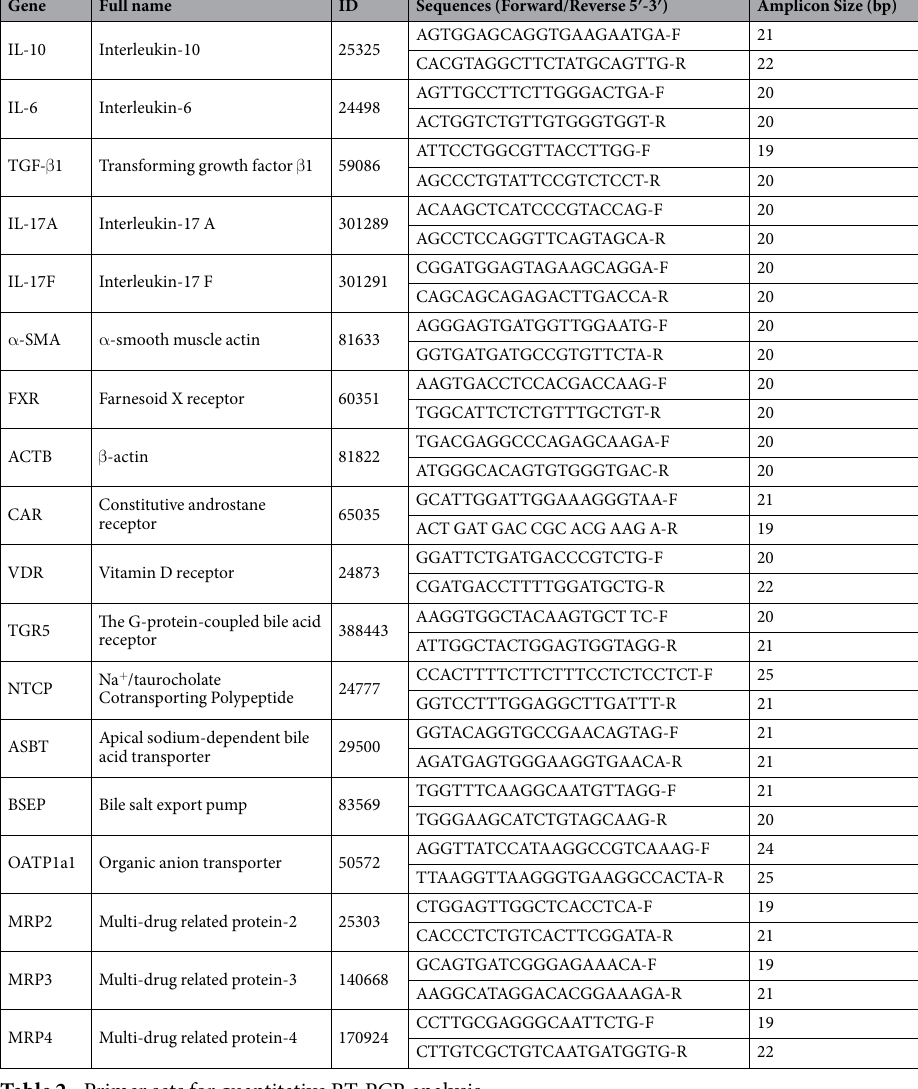
Table 2. Primer sets for quantitative RT-PCR